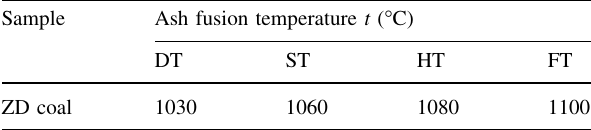
Table 3 Ash fusibility characteristics of ZD coal